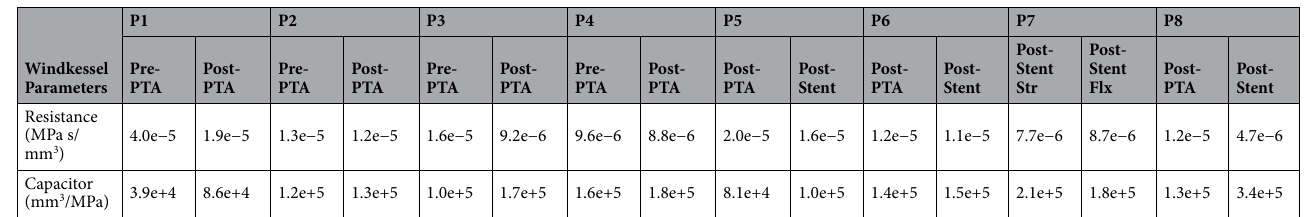
Table 4. Parameters for the two-element Windkessel model.